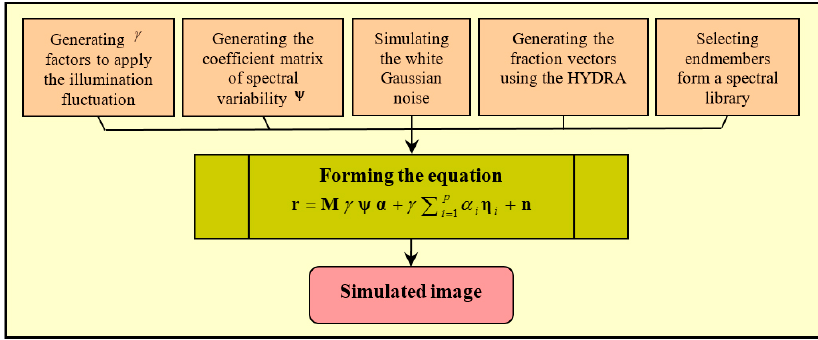
Figure 5. Flowchart of generating the simulated images.